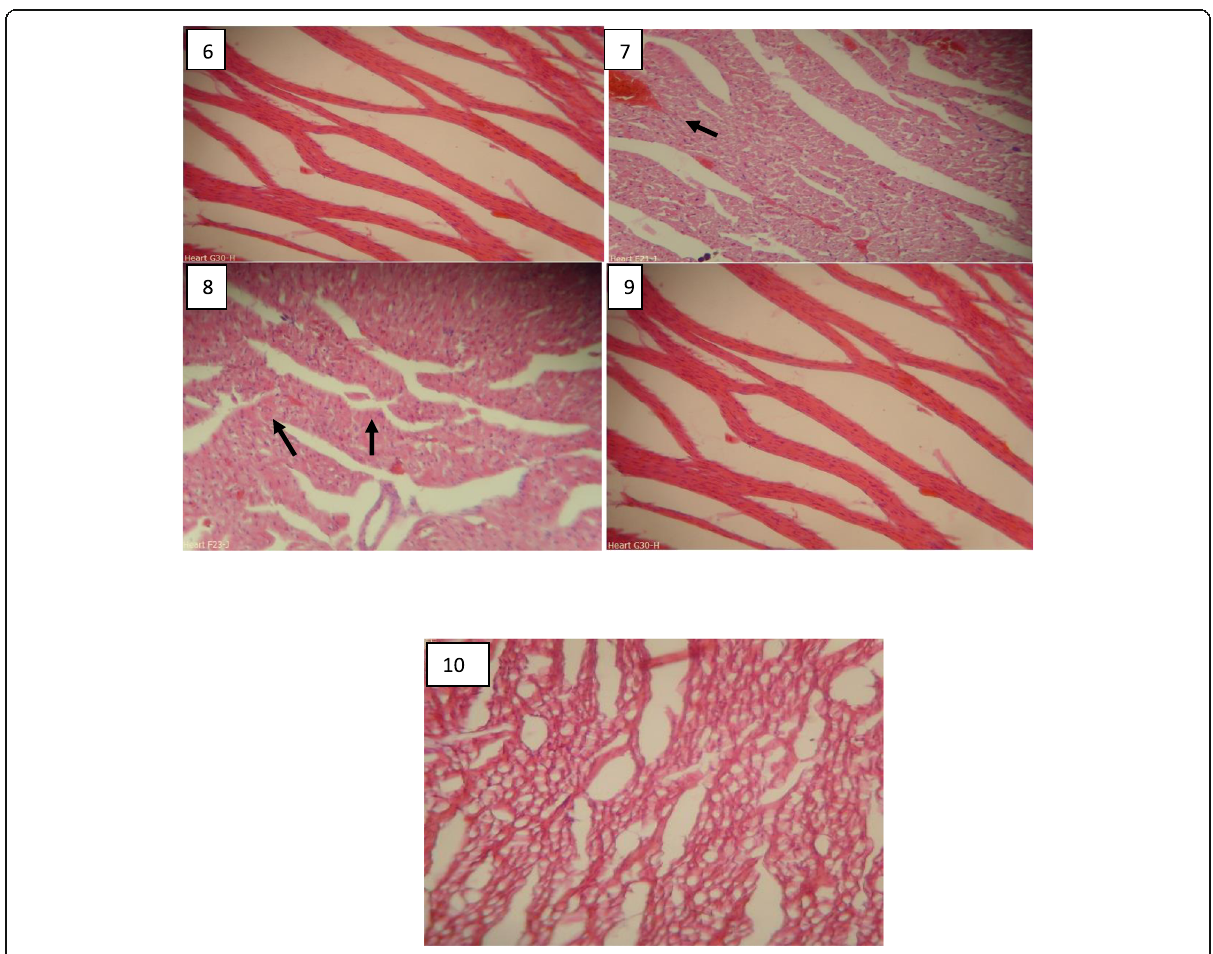
Fig. 2 Histological Sections of the Heart. Plate 6 : Group (1): given continuous salt load. Showing normal cardiac muscle fibres. Plate 7 : Group (2): given salt load and aqueous extract. The arrow indicates haemorrhage and congestion in blood vessels. Plate 8 : Group (3): given salt load and ethanolic extract. The arrows indicate haemorrhage and distorted blood vessels. Plate 9 : Group(4): given salt load and distilled water, shows normal cardiac muscle fibres. Plate 10 : Control group (5): given distilled water Shows normal cardiac muscle